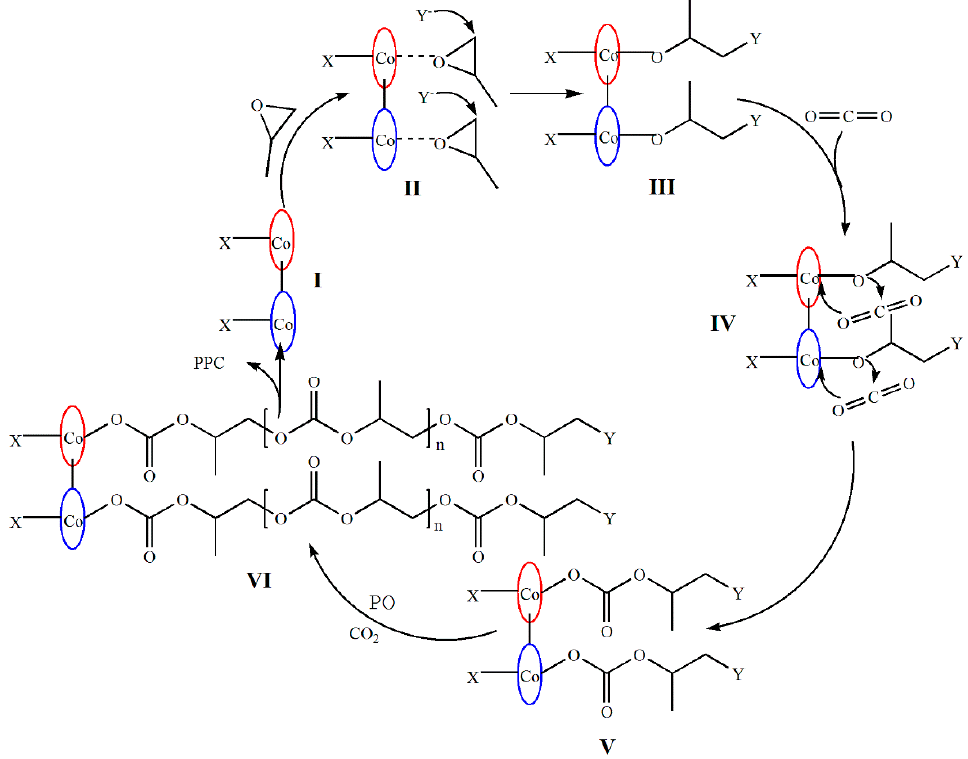
/ PO copolymerization with the dinuclear 2